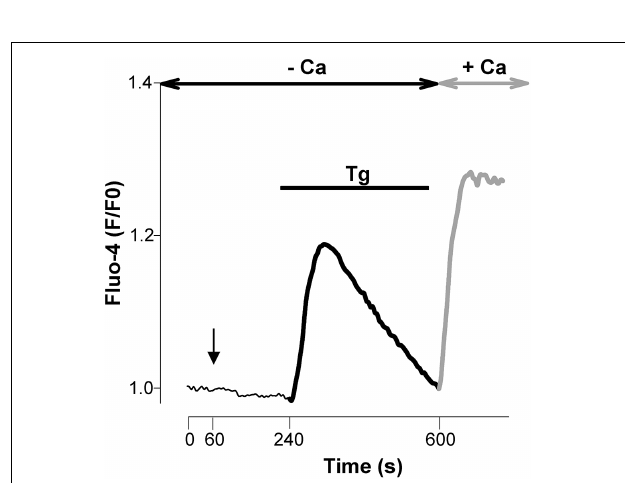
FIGURE 2 | Emptying intracellular pools of Ca 2 + with thapsigargin controls an entry of Ca 2 + . Unless otherwise indicated, the experimental protocol used throughout this study is illustrated in this figure. E13 cortical neurons loaded with Fluo-4 were maintained in a Ca 2 + -free saline. Thapsigargin (Tg, 200 nM) was added 240 s after the beginning of the recording and then washed away prior to the re-admission of Ca 2 + (2 mM) into the recording saline medium (at time 600 s). Thick dark line: release of Ca 2 + evoked by Tg; thick gray line: Ca 2 + entry triggered by the emptying of the Ca 2 + stores (SOCE). When used, blockers of channels were applied at time + 60 s (vertical arrow) and remained present till the end of the